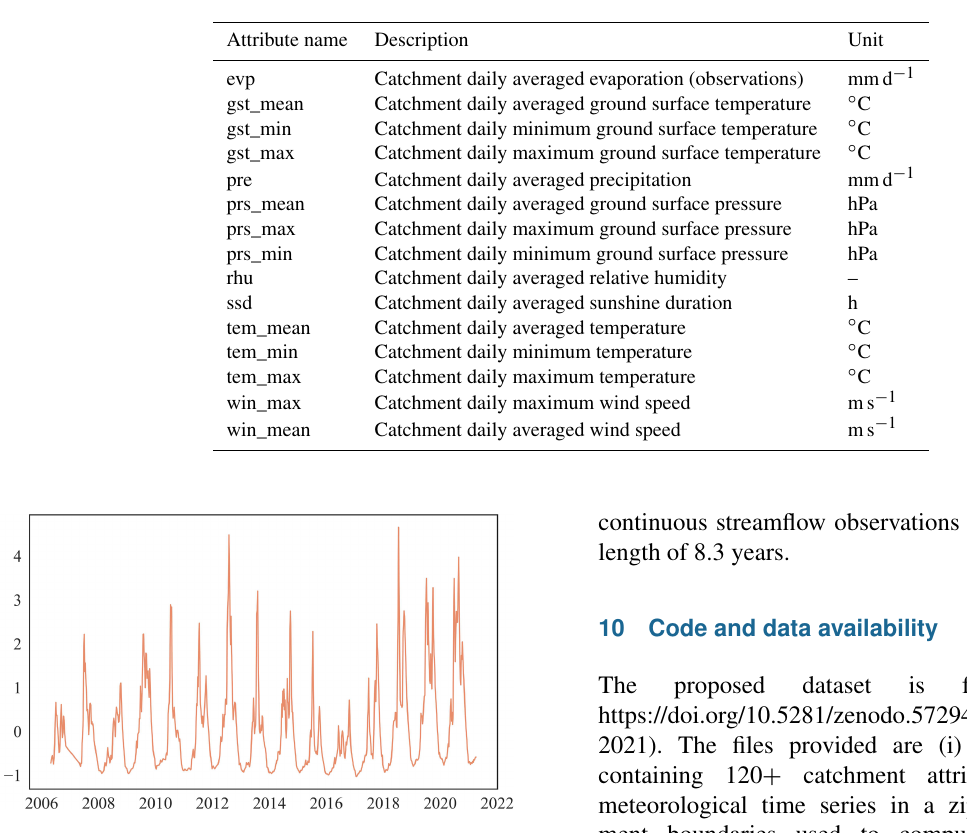
Table 4. Meteorological variables provided in HydroMLYR.